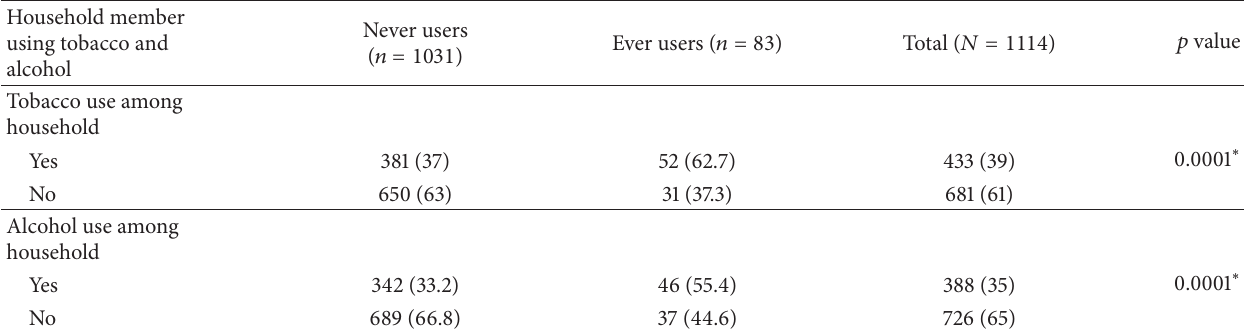
Table 2: Association between tobacco use and household member using tobacco or